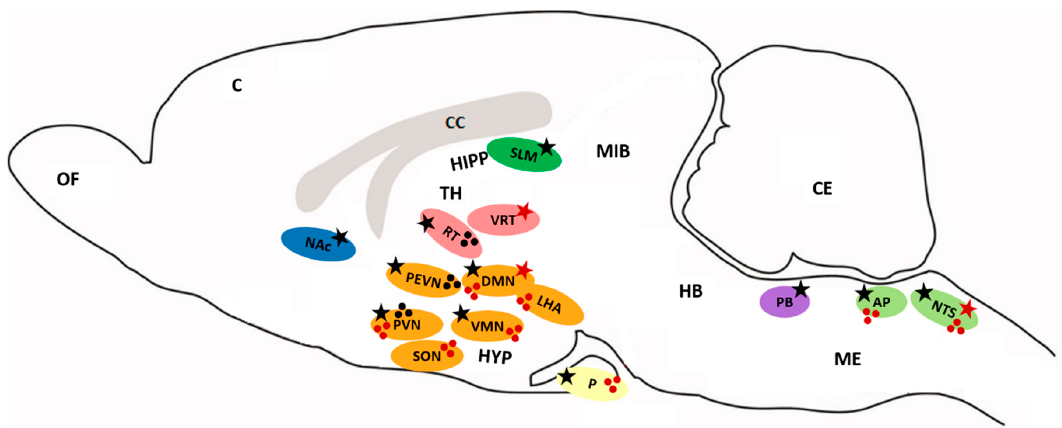
Figure 1. Distribution of PrRP and GPR10. Ellipses represent distinct brain areas (blue—nucleus accumbens, grey—corpus callosum, green—hippocampus, red—thalamus, orange—hypothalamus, yellow—pituitary, violet—parabrachial nucleus, light green—medulla oblongata). Stars mark the expression of mRNA (red star— PrRP , black star— GPR10 ). Spots represent the distribution of PrRP (red), GPR10 (black) cell bodies and fibers. AP: area postrema, C: cerebral cortex, CC: corpus callosum,